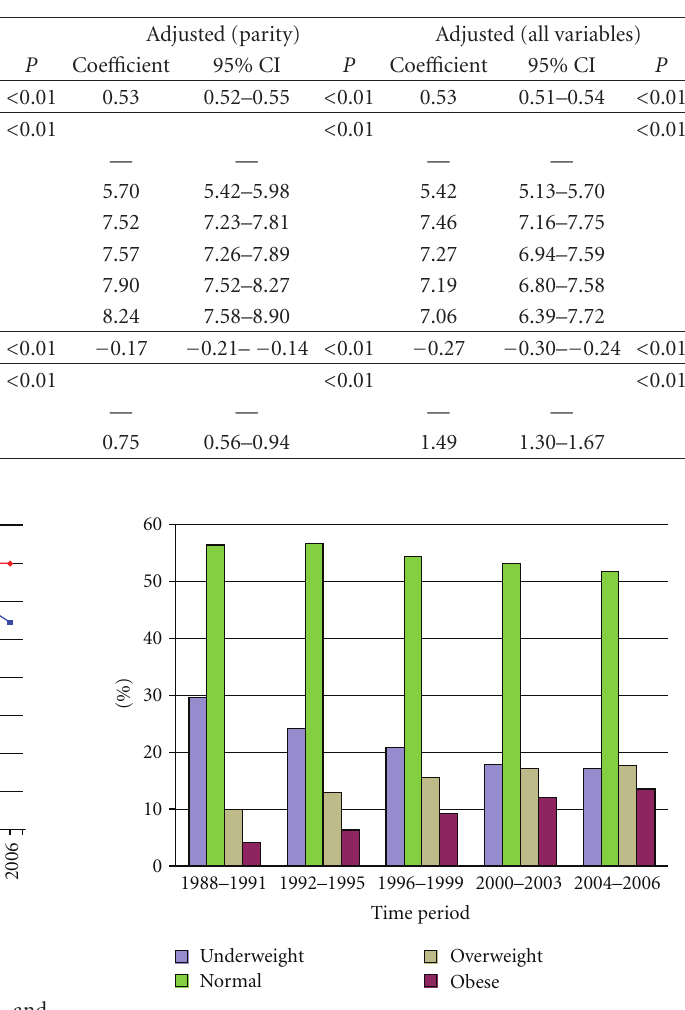
Figure 2: Percentage of women classified as underweight ( < 55kg), normal weight (55–75 kg), overweight ( > 75–90 kg), and obese ( > 90kg) by time period, 1988–2006.